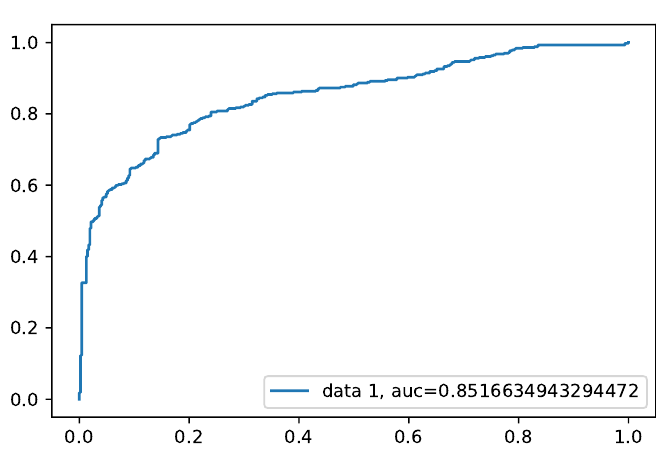
Figure 7. Confusion matrix for case study 2.